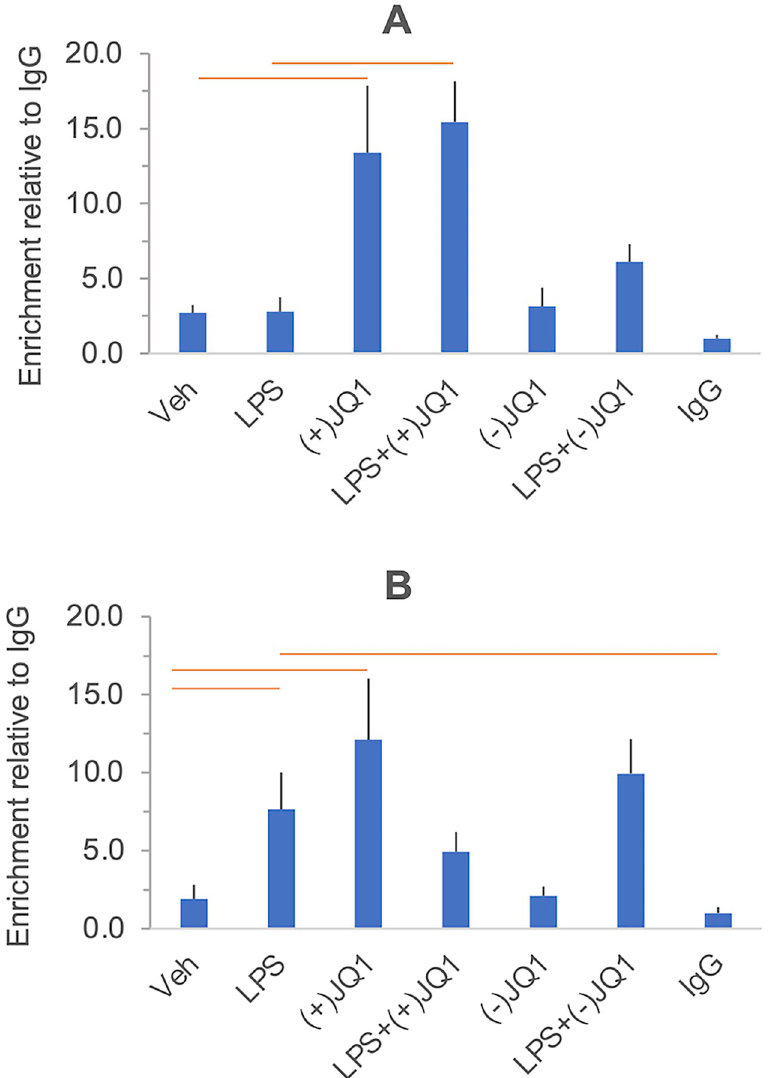
Fig 8. The effects of LPS, (+)-JQ1, and (-)-JQ1 on histone 3 acetylation at the IL10 (Panel A) and IDO1 (Panel B) promoters in DSCs. Primary cultures of DSCs were treated with vehicle, LPS, (+)-JQ1, (-)-JQ1, and their combinations as indicated under the columns. Histone 3 acetylation was determined by chromatin immunoprecipitation (ChIP). Columns show the mean ± SEM, n = 5–6 independent experiments. Significant differences (at 5% FDR), highlighted in the heatmap in Fig 6, are indicated by the horizontal orange and blue lines. Further details are described in the legend in Fig 7. The results of the individual experiments and summary statistics are presented in the S1